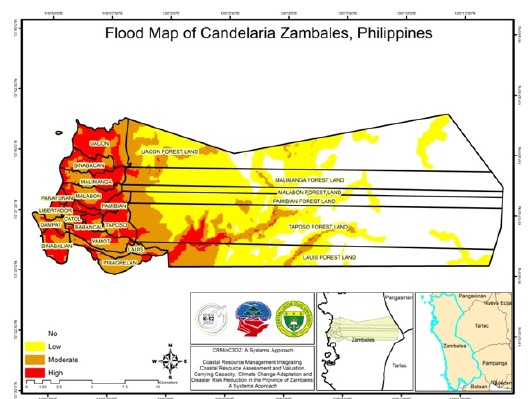
Figure 10. Flood hazard susceptibility of Candelaria, Zambales For the flood hazard susceptibility of Masinloc, Zambales, Table 7 shows that 15% of total land area were found to be highly susceptible, 17% had moderate susceptibility, and 23% had low susceptibility, and forty five percent (45%) had not affected by flooding. In terms of area affected, six (6) of the thirteen (13) barangays were highly susceptible to flooding (Baloganon, Bani, Collat, North Poblacion, South Poblacion, and Tapuac). These areas have poorly drained soil that produces increase surface run-off. Barangays Bamban and Sto. Rosario were moderately susceptible, and Barangay San Salvador was the least susceptible to flooding (Table 8).